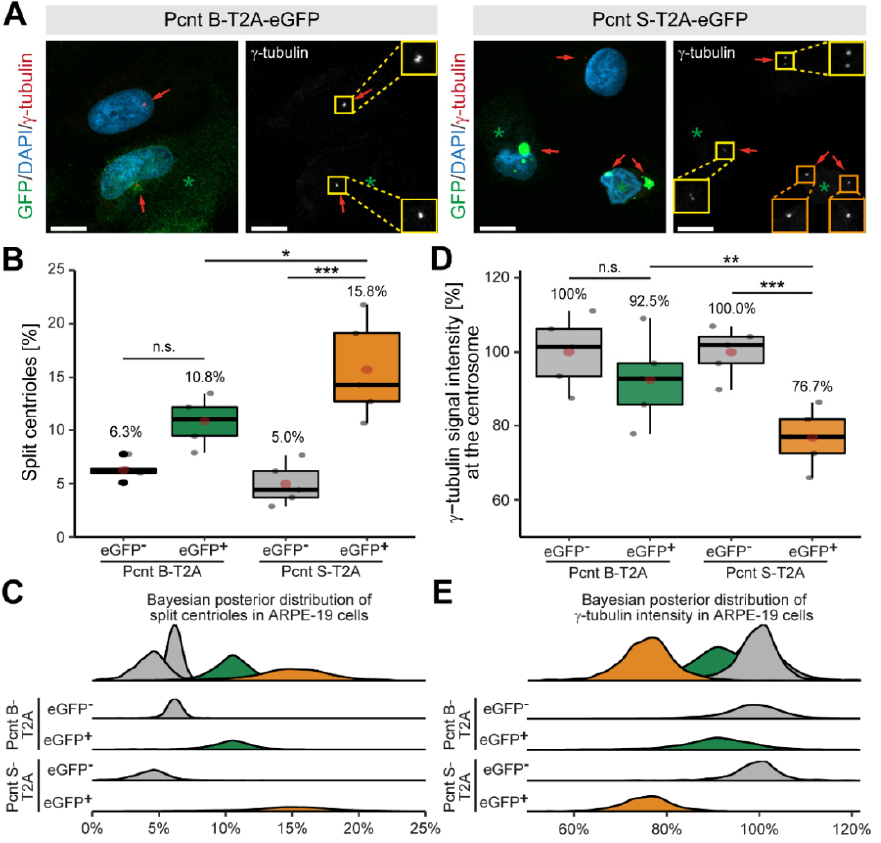
Figure 4. Ectopic expression of Pcnt S induces centriole splitting and reduction in centriolar γ -tubulin in ARPE-19 adult retinal pigment epithelial cells. ( A ) Representative examples of ARPE-19 cells transfected with the bi-cistronic plasmid encoding Pcnt B-T2A-eGFP or Pcnt S-T2A-eGFP (GFP, green) and immunostained with anti- γ -tubulin antibody (centrioles, red). Nuclei were visualized with DAPI (DNA, blue). Yellow box: paired centrioles. Orange box: split centrioles. ( B , D ) Quantitative analysis of the percentage of cells showing centriole splitting ( B ) and normalized γ -tubulin intensity at the centrioles compared to non-transfected cells (GFP - ) ( D ) upon Pcnt isoform expression as indicated. ( C , E ) Bayesian posterior distribution for the data in ( B , D ). Green asterisk: GFP + cell. Red arrow: centriole: Scale bars: 10 µm. Data are median ± quartiles and mean (red point), n = 3, n.s.: p > 0.05, *: p < 0.05, **: p < 0.01, ***: p < 0.001.